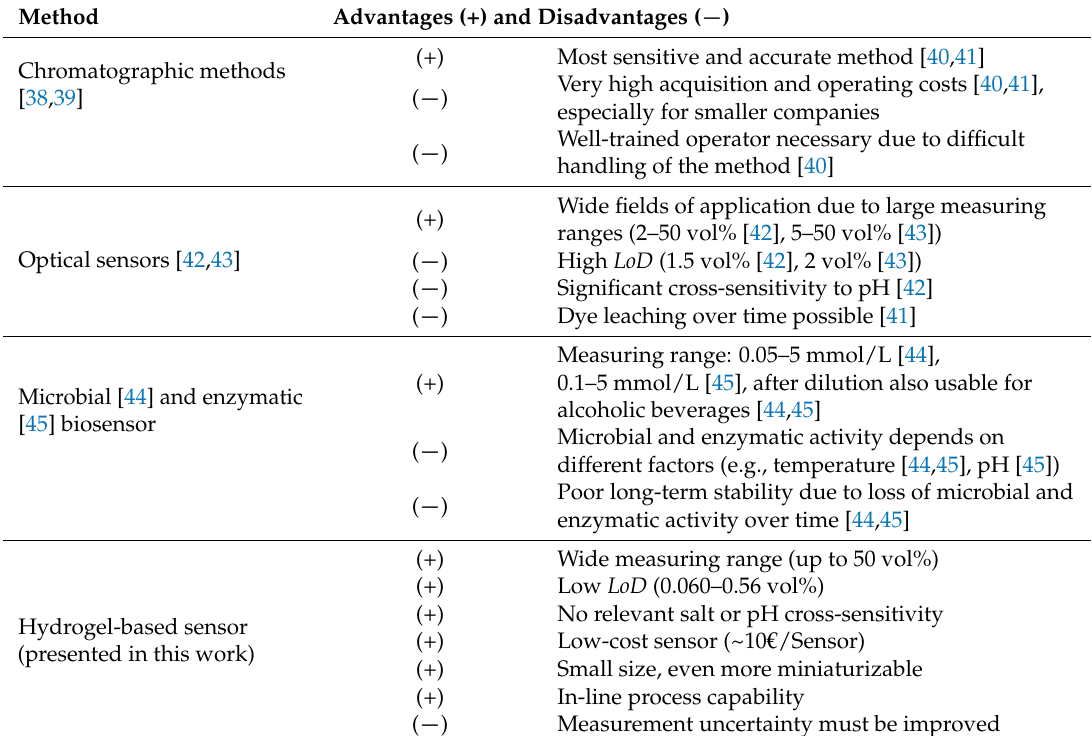
Table 1. Ethanol sensor concepts and their advantages and disadvantages—a